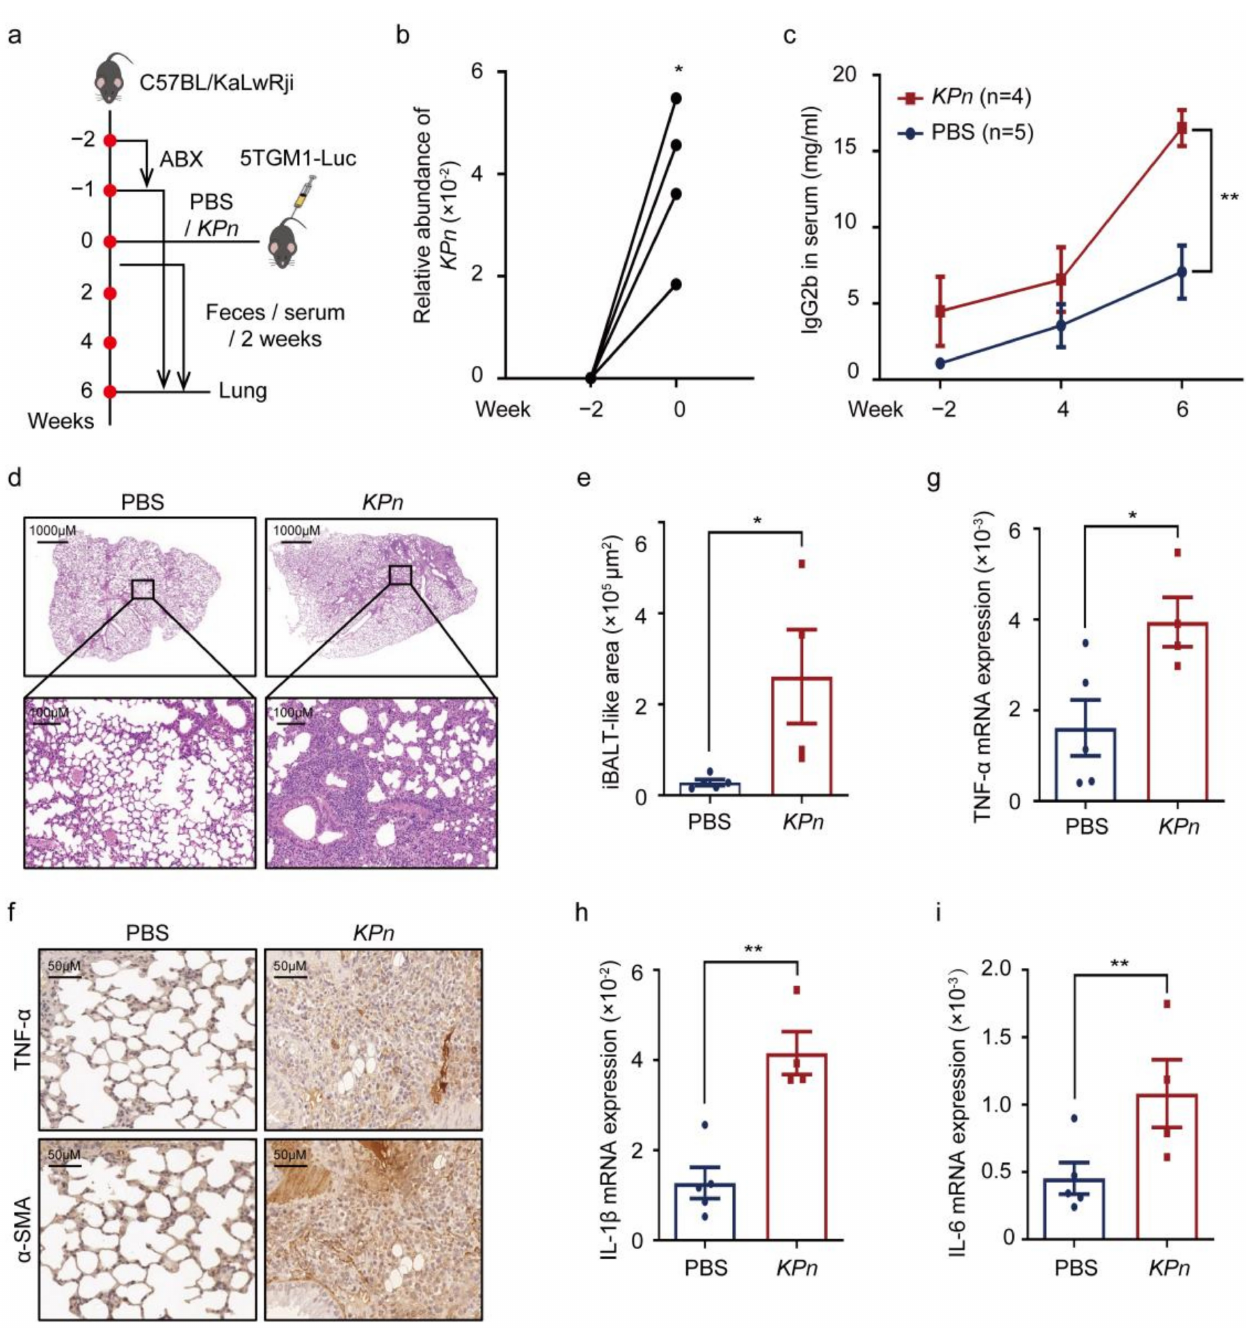
Figure 2. Intestinal K. pneumonia accelerates pneumonia in 5TGM1 MM mice. ( a ) Schematic of intestinal K. pneumonia transplantation experimental workflow; ( b ) relative abundance of intestinal K. pneumonia in K. pneumonia colonized mice at week − 2 and week 0; ( c ) serum IgG2b concentra- tions in PBS gavaged mice (PBS) and K. pneumonia colonized mice ( KPn ) by ELISA (mean ± SEM); ( d ) representative images of H&E staining of the lung from PBS and KPn group; ( e ) the iBALT-like area in PBS and KPn group (mean ± SEM); ( f ) representative images of immunohistochemistry staining of TNF- α and α -SMA in the lung from PBS and KPn group; ( g – i ) mRNA expression of TNF- α , IL-1 β , and IL-6 in the lung from PBS and KPn group by using qPCR (mean ± SEM); * p < 0.05, ** p < 0.01; p -values were calculated using two-tailed unpaired Student’s t -tests ( c , e , g – i ); p -value was calculated using paired Student’s t -test ( b